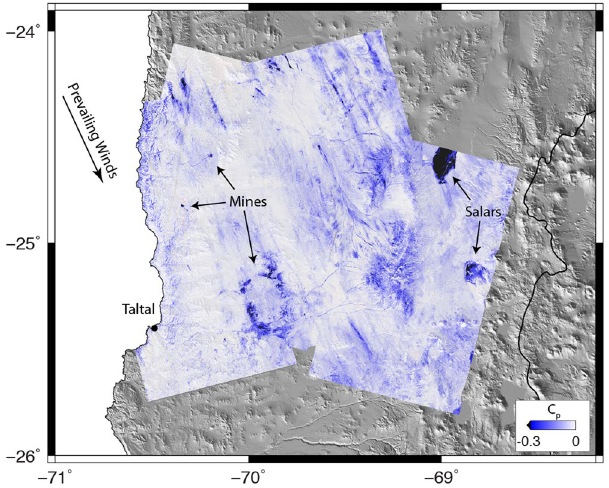
Figure 5. Permanent coherence loss, C p . Permanent coherence loss between dates before and after the March extreme precipitation event, C p , for all three tracks used in this study. Negative values (blue) indicate regions where land was disturbed during the event, values <− 0.3 are in black. Dry lake beds (salars) and mines were particularly affected. Note that the NNW-trending streaks, which otherwise might be attributed to ionospheric effects on a particular date, are continuous from track to track and are nearly identical in the areas of overlap. These likely indicate real surface disturbance and are aligned with the prevailing winds active during the March event 37, 38 . Figures generated using Generic Mapping Tools 50 , v.